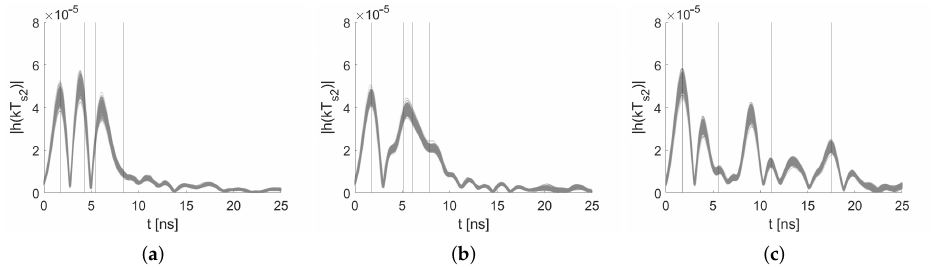
Figure 9. Pre-processed CIR measurements in idle target area. ( a ) Idle CIR measurements of sensor pair (1,2). ( b ) Idle CIR measurements of sensor pair (1,3). ( c ) Idle CIR measurements of sensor pair